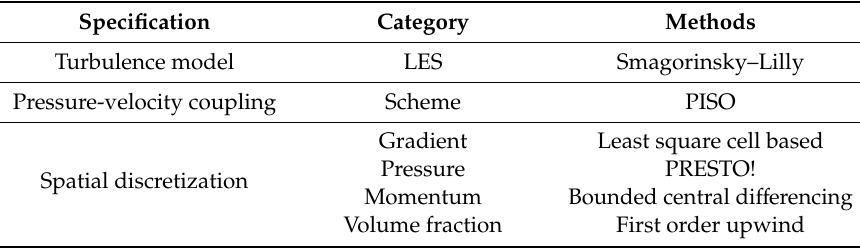
Table 3. Model and numerical solution methods.